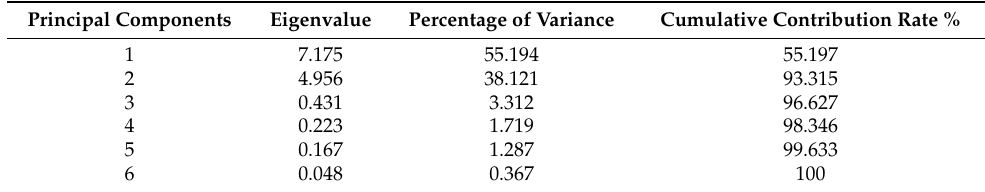
Table 2. Cumulative contribution rate of principal